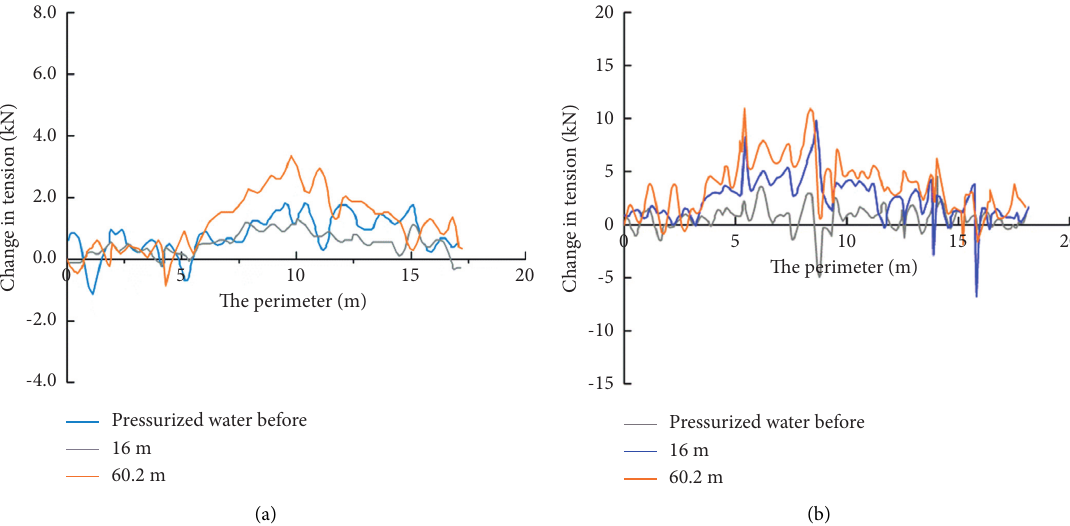
Figure 2: Test result curve of the distributed fiber intelligent steel strands during the section water pressure test: (a) section 1; (b) section